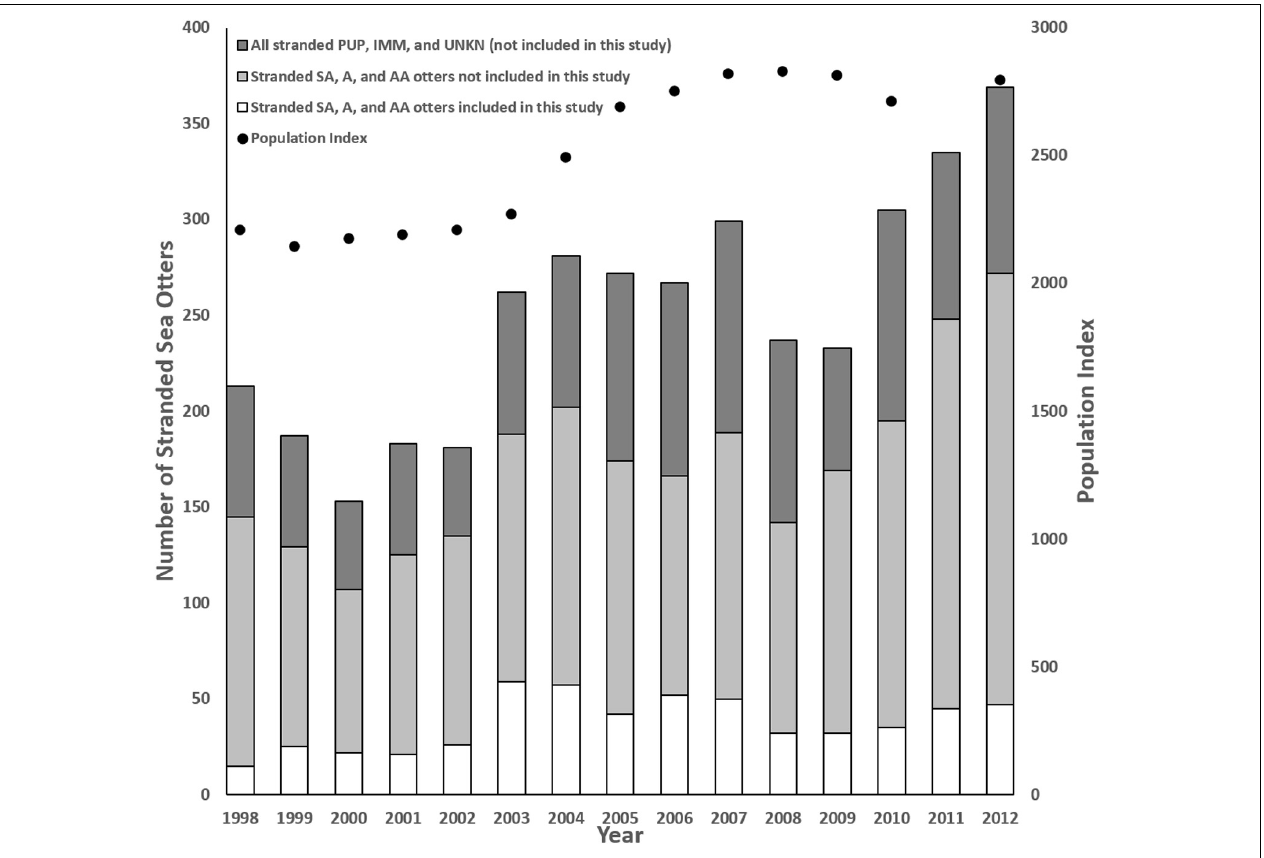
FIGURE 1 | Comparison of annual southern sea otter ( Enhydra lutris nereis ) carcass stranding patterns, the annual population index (data missing for 2011), and the number of subadult (SA), adult (A) and aged adult (AA) carcasses collected vs. examined for this study, along with all animals of unknown age class (UNKN), pups (PUP), and immature (IMM) sea otters that were excluded because limited numbers received detailed necropsies during this period